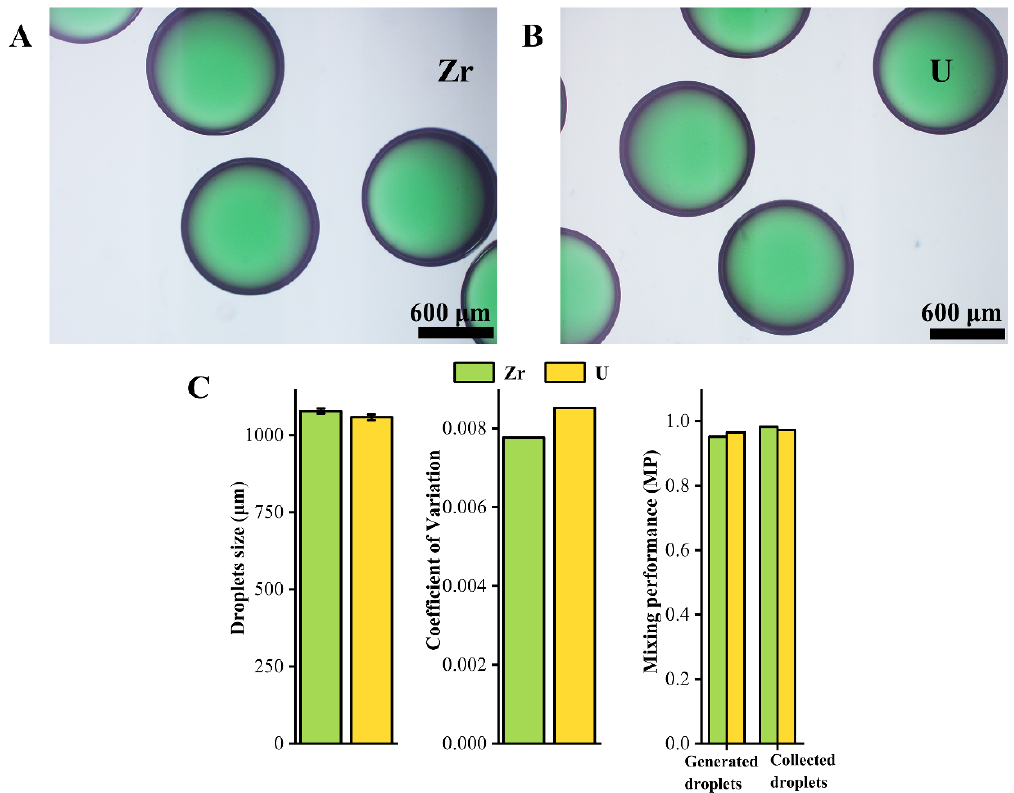
Figure 9. ( A ) Collected droplets of simulated zirconium broth by DMS. ( B ) Collected droplets of simulated uranium broth by DMS. ( C ) Characterization of droplets.